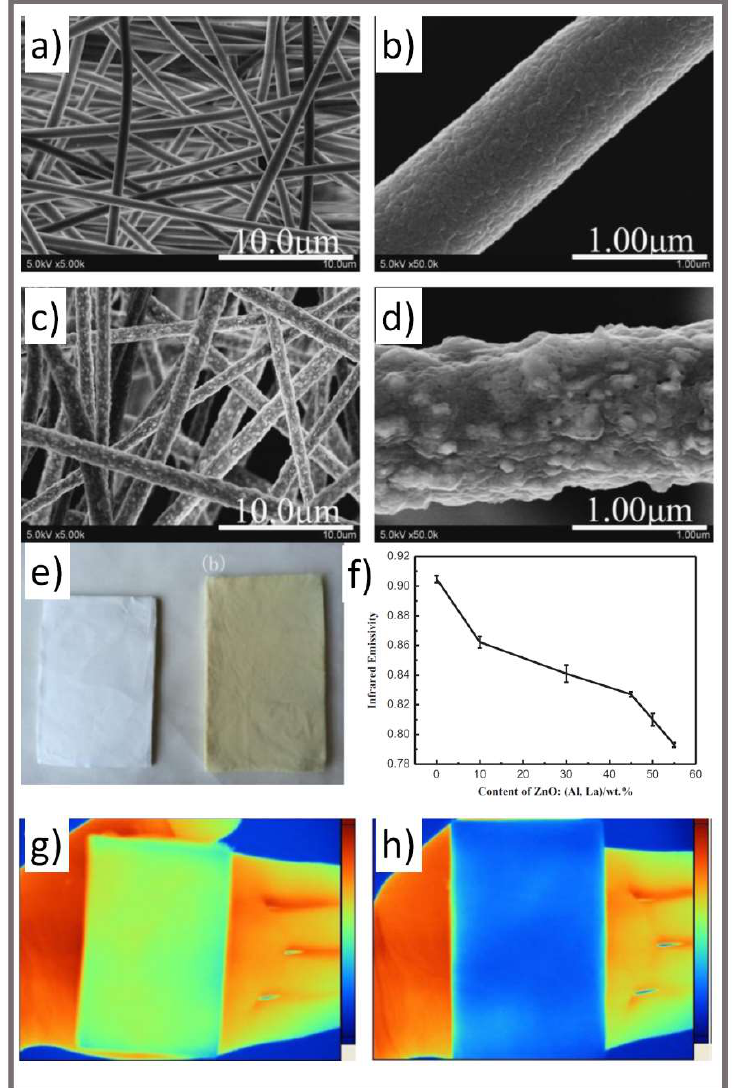
Figure 4. ( a , b ) Field emission scanning electron microscope (FE-SEM) images of electrospun pure PAN nonwoven fabrics. ( c , d ) FE-SEM images of electrospun ZnO:(Al, La)/PAN nanocomposite nonwoven fabrics. ( e ) Images of pure PAN and nanocomposite electrospun nonwoven fabrics, respectively. ( f ) Change in the IR emissivity vs. the nanoparticle loading. ( g , h ) IR images of the pure PAN and 55 wt.% ZnO:(Al, La)/PAN nonwoven fabrics, respectively (reprinted from [42] with permission from Elsevier).